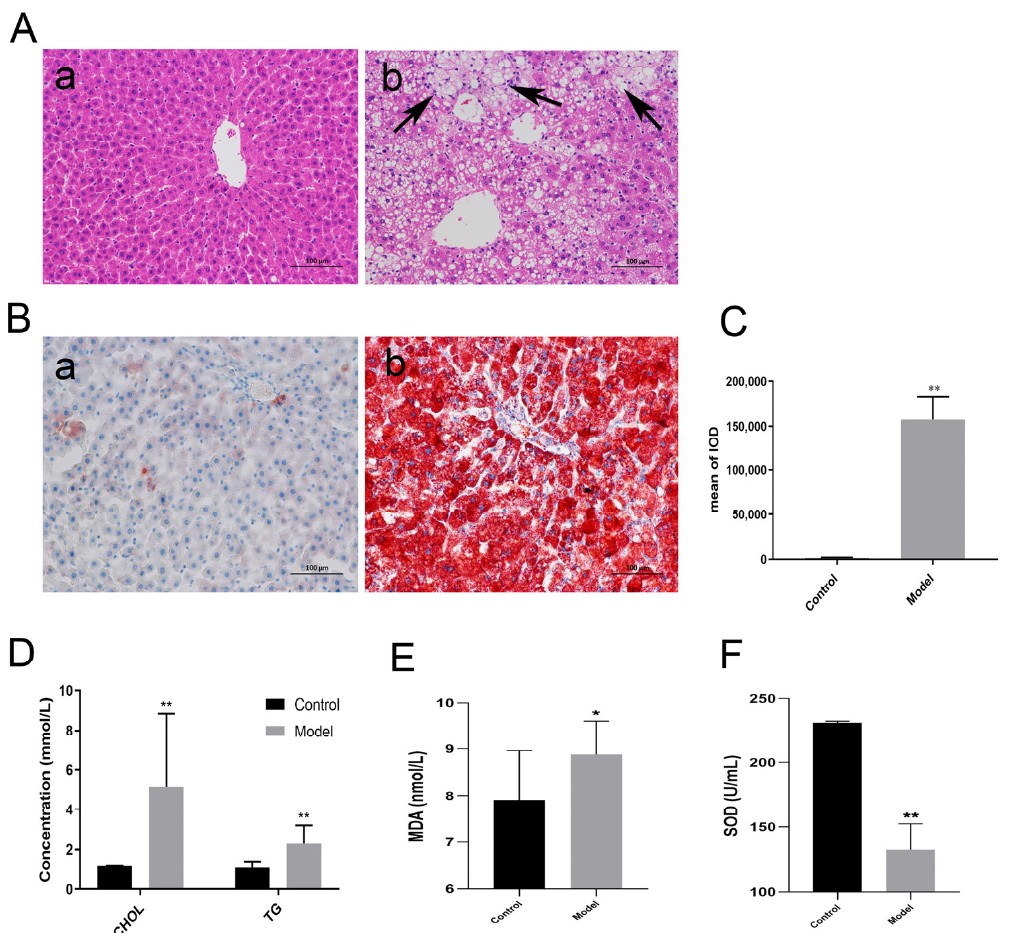
Figure 1. Establishment of NAFLD model. ( A ) The histopathological examination by H&E (200 × ). ( a ): Normal control group; ( b ): NAFLD model group. The black arrows indicate lipid droplets and inflammatory infiltrate. ( B ) Oil red o ( × 200) staining in control ( a ) and model ( b ) groups. ( C ) Quantitative analysis of oil red staining. IOD: integral optical density. ( D ) The level of CHOL and TG in the liver. ( E ) The concentration of MDA in serum. ( F ) The concentration of SOD in serum. Data are exhibited as the mean ± SD (n = 10/group). * indicates p < 0.05, ** indicates p < 0.01.